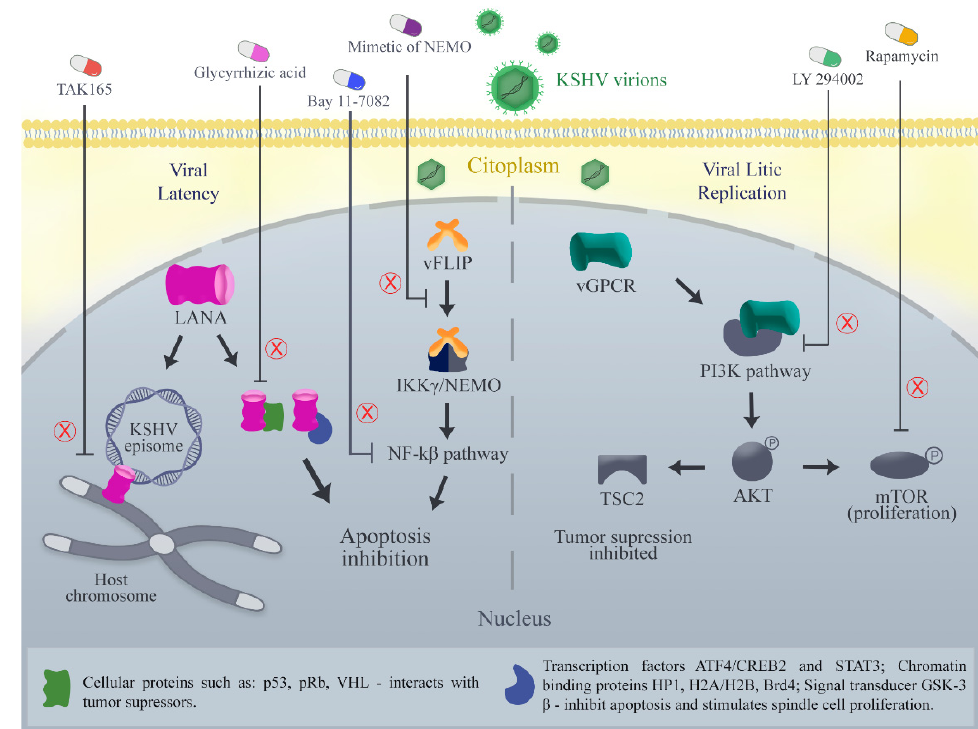
Figure 1. Therapeutics targets in signaling pathways modulated by Kaposi sarcoma-associated virus (KSHV) oncoproteins. The pathways shown include PI3K/Akt/mTOR associated with vGPCR (lytic oncoprotein), NF-kB associated with vFLIP (latency oncoprotein), and different pathways associated with LANA (latency oncoprotein). A total of 5 therapies are represented outside the cell and their respective targets are indicated with the letter “X” in red color.